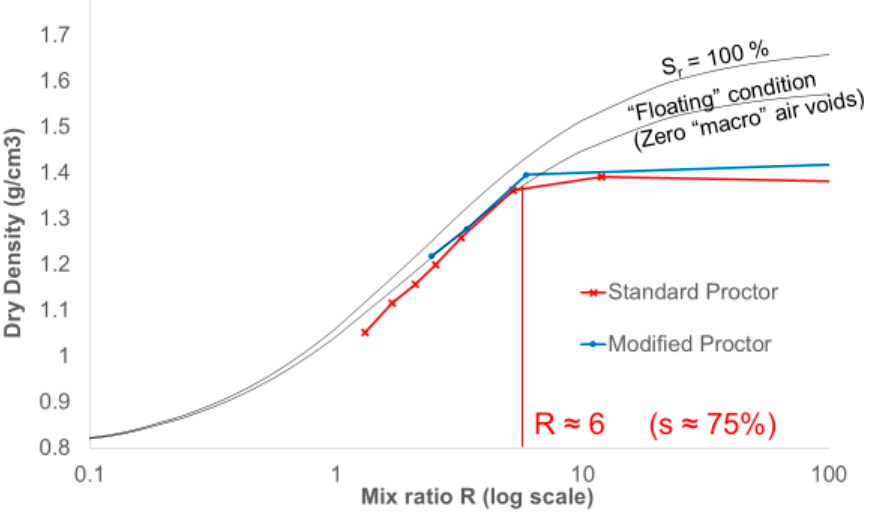
Figure 11. Dry density with respect to mix ratio for oil sands tailings–clay shale blends compacted using the standard and modified Proctor method.